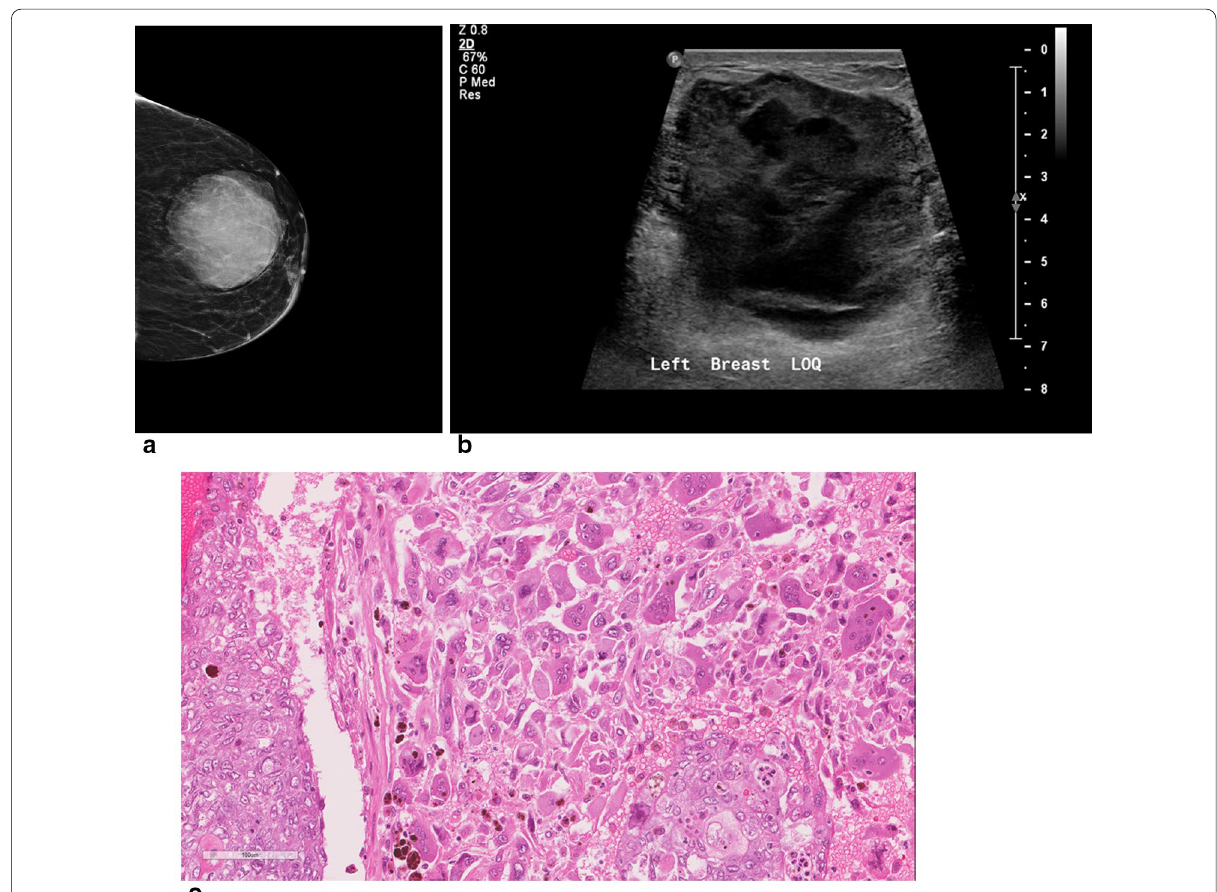
Fig. 3 A large left breast mass in an 82-year-old woman with mesenchymal differentiation subtype. a The craniocaudal view of mammogram shows a rounded, dense mass with circumscribed margins and mild periareolar skin thickening. b The ultrasound shows an irregular shaped mass with indistinct margins along with complex echotexture and posterior enhancement. c The pathology shows a metaplastic carcinoma with mesenchymal differentiation showing prominent multinucleated giant